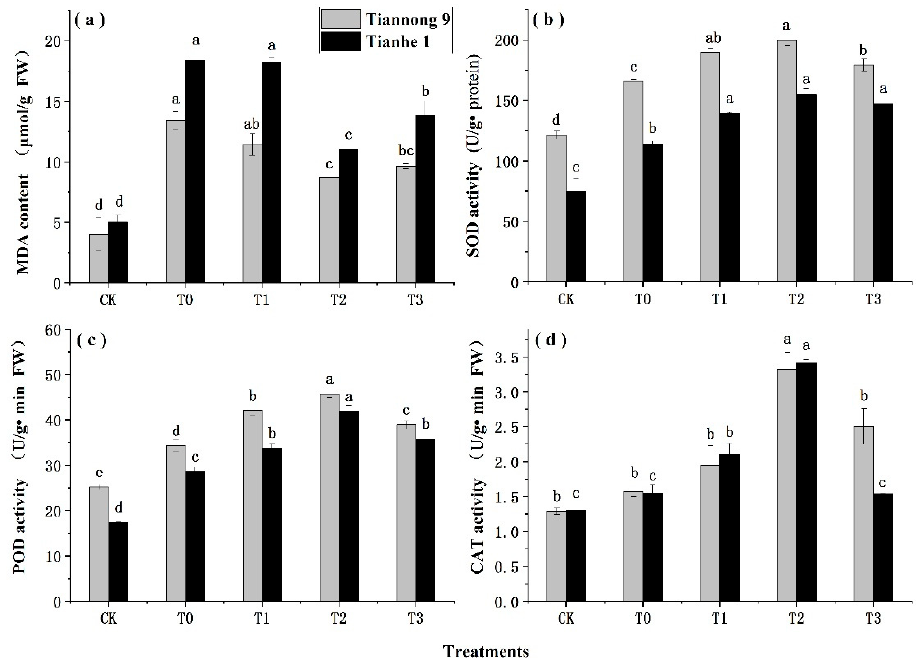
Figure 2. E ff ects of di ff erent concentrations of BL on the MDA content and antioxidant enzyme activity Figure 2. Effects of different concentrations of BL on the MDA content and antioxidant enzyme of maize seedlings under chilling stress. CK treatment at 25 ◦ C with distilled water, T0 treatment with activity of maize seedlings under chilling stress. CK treatment at 25 °C with distilled water, T0 BL at 0.00 mg / L, T1 treatment with BL at 0.01 mg / L, T2 treatment with BL at 0.1 mg / L, T3 treatment treatment with BL at 0.00 mg/L, T1 treatment with BL at 0.01 mg/L, T2 treatment with BL at 0.1 mg/L, with BL at 1 mg / L. The data represent the means of independent measurements with three replicates. T3 treatment with BL at 1 mg/L. The data represent the means of independent measurements with The mean values marked with di ff erent letters di ff er significantly at p < 0.05. ( a ) The variation trend of MDA content. ( b ) The variation trend of SOD activity. ( c ) The variation trend of POD activity. ( d ) The variation trend of CAT